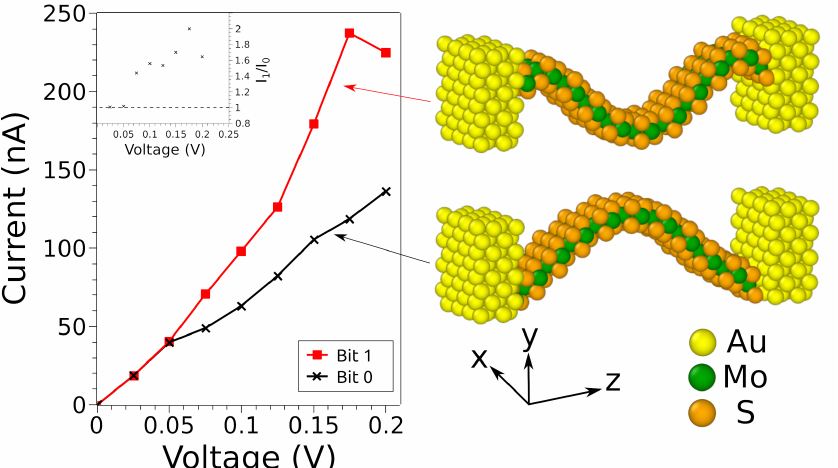
Figure 5. Current–Voltage characteristic curve of the asymmetric clamping configuration for a compression of ≈ 15%. The current increased by increasing the voltage bias across the device. For the two different configurations, pictured on the right, two different values of current for the same voltage are achieved. Inset shows the ratio I 1 / I 0 , which is above 40% for bias voltage greater than 0.05